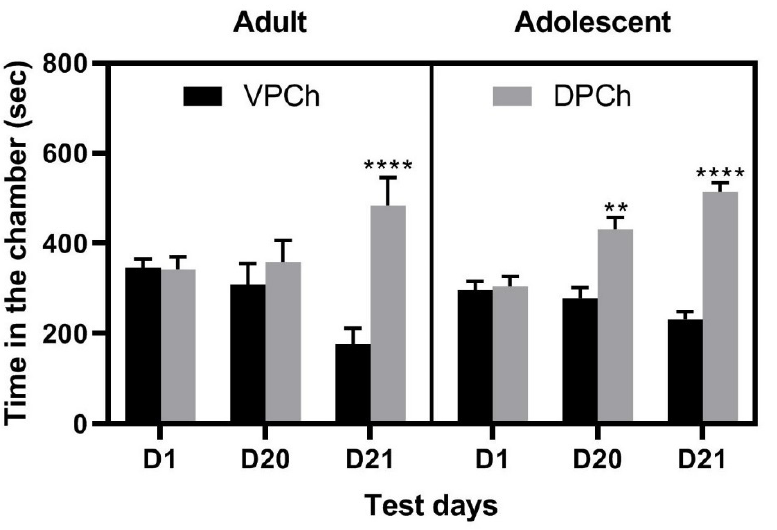
Figure 2. CPP induced by a single amphetamine conditioning in control adolescent and adult C57BL/6J mice. Male and female mice of both age groups ( n = 7–8 mice per sex and age group) were tested for baseline and then given conditioning with saline in both place conditioning chambers.